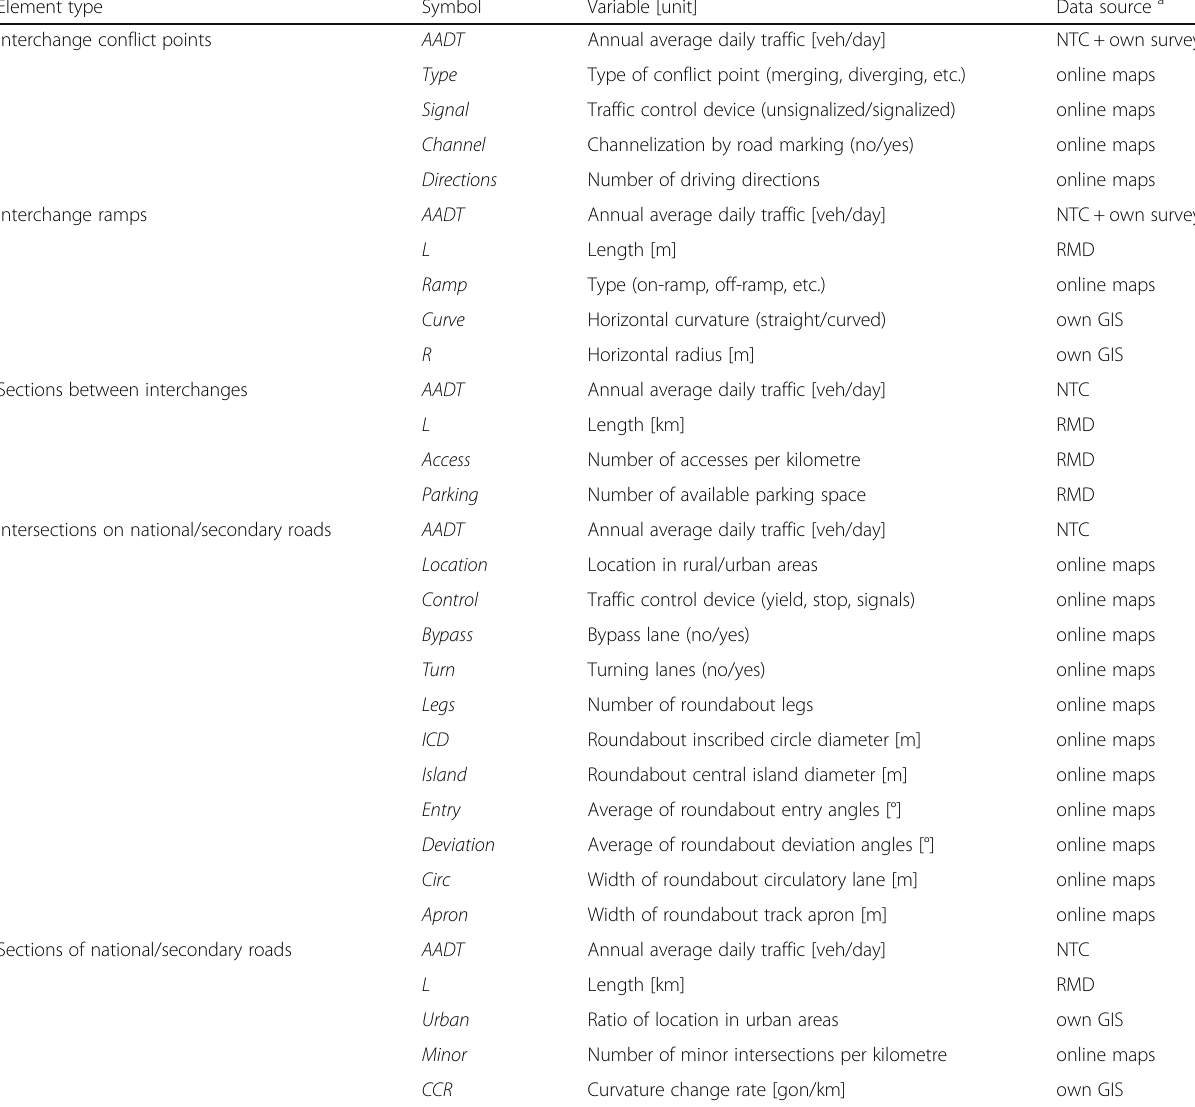
Table 2 List of explanatory variables, with their symbol, unit and data source Element